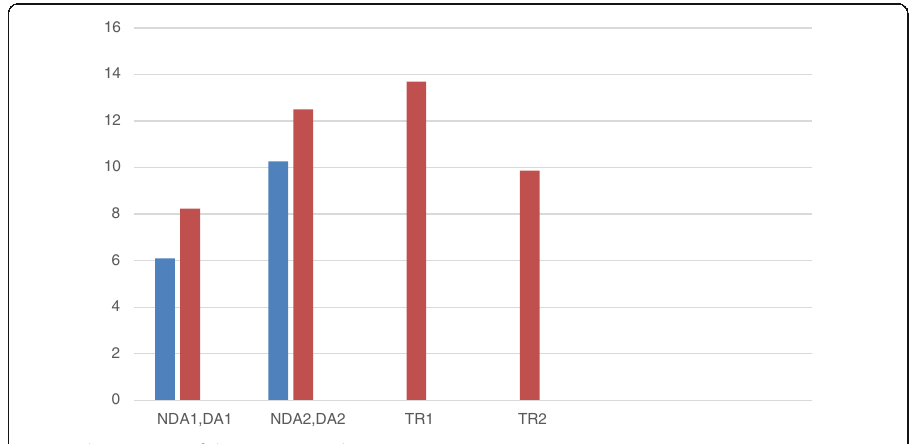
Fig. 2 The progress of the experimental